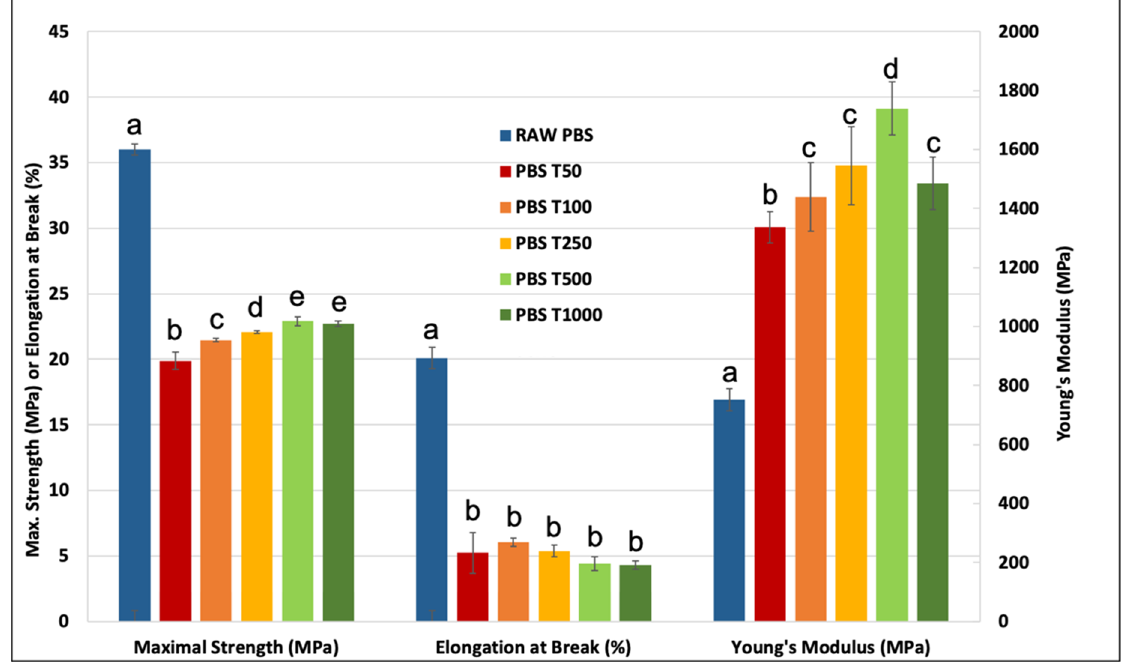
Figure 5. Tensile mechanical properties of PBS–tomato biomass composite materials. Letters indicate the statistical differences between the mechanical values. When letters are different, the property is significantly different.